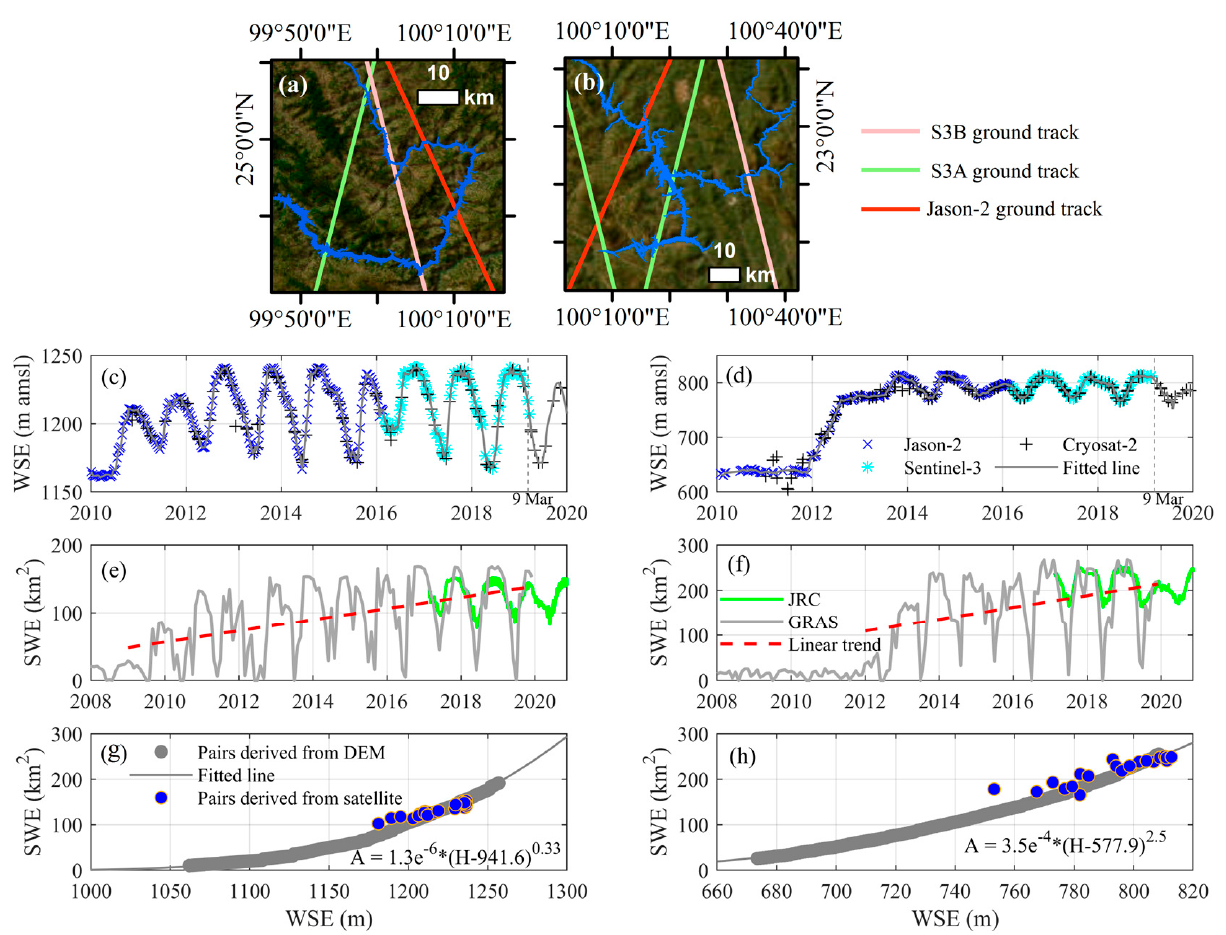
Figure 5. The water bodies of ( a ) Xiaowan and ( b ) Nuozhadu reservoirs. The water surface eleva- tions (WSE) derived from Jason-2. Sentinel-3, and Cryosat-2 in ( c ) Xiaowan and ( d ) Nuozhadu reservoirs. The surface water extents (SWE) provided by JRC and GRAS in ( e ) Xiaowan and ( f ) Nuozhadu reservoirs. The relation curves fitted by altimetry-derived WSE and GRAS-derived SWE in ( g ) Xiaowan and ( h ) Nuozhadu reservoirs.